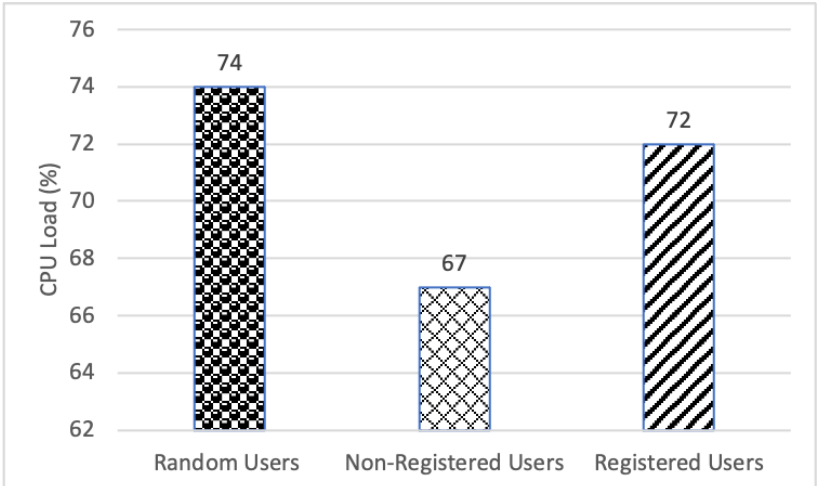
Figure 4. Average SIP server CPU loads for registered, nonregistered, and random users (3 min after the SIP-DRDoS attack was